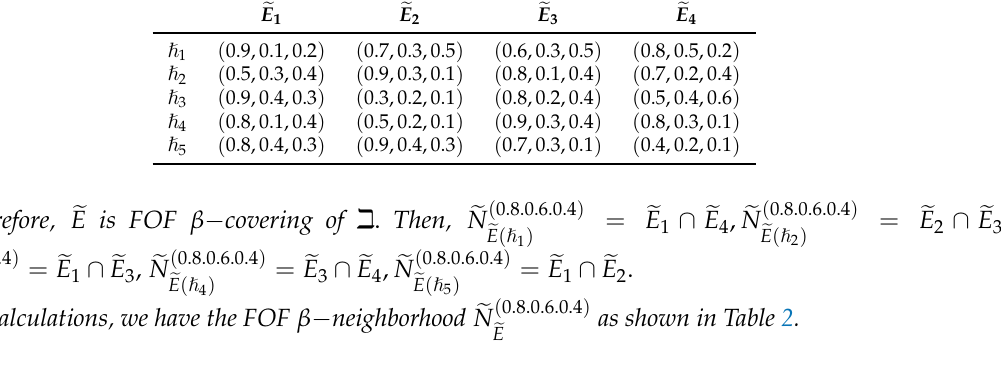
( 0.8.0.6.0.4 ) in Example (cid:101) E